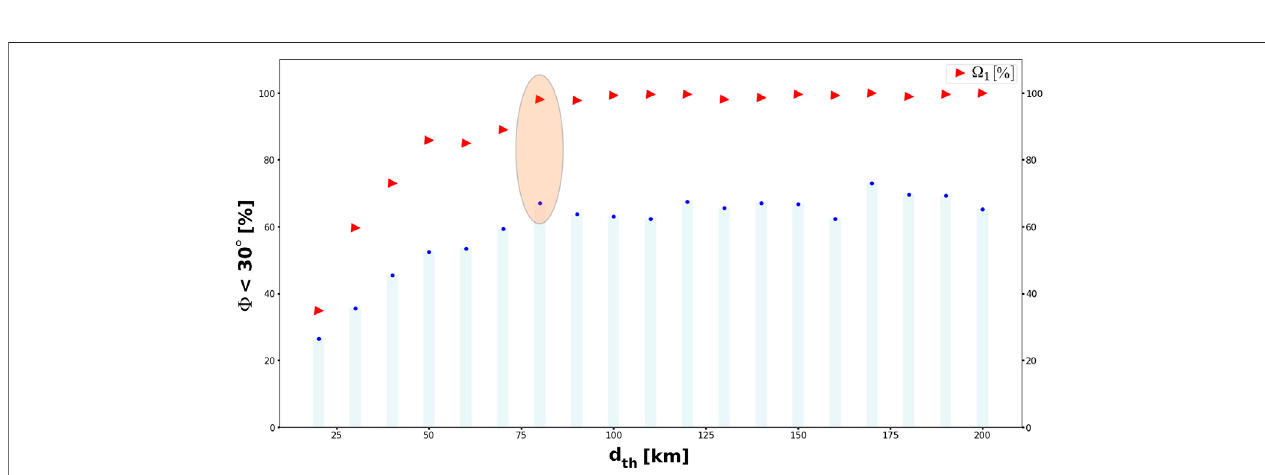
FIGURE4| Exampleoftheselectionprocessoftheoptimal d thparameter.Redmarkersshowthepercentageofeventswithatleastoneneighborinsidethesphere( Ω 1 ).Bluemarks indicate the percentage of events with at least one FM solution with Φ < 30 ° . Ellipse indicates the optimum d th considered in the study as the in fl ection point in both curves.